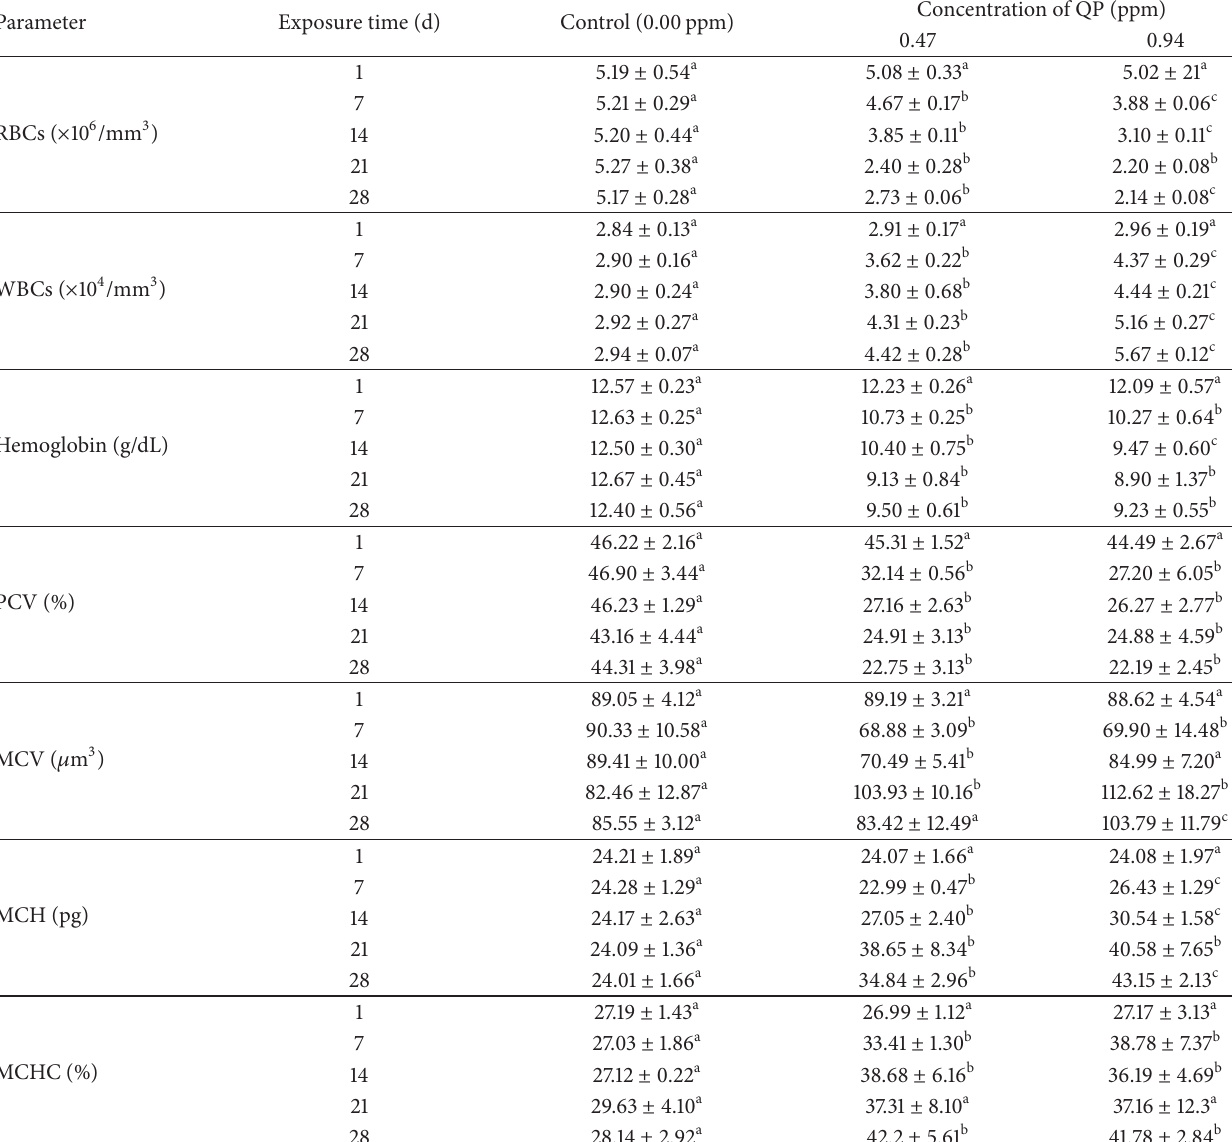
Table 1: Mean hematological parameters of silver barb exposed to sublethal concentrations (0.47 and 0.94 ppm) of QP in 1, 7, 14, 21, and 28